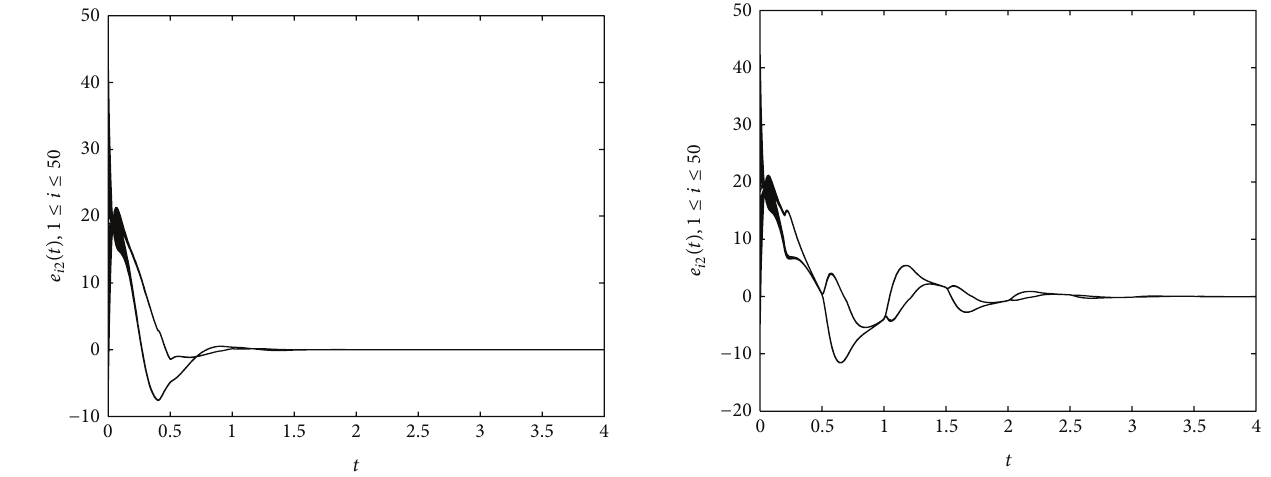
Figure 6: Synchronization errors 𝑒 𝑖 2 , 1 ≤ 𝑖 ≤ 50, with control parameters 𝑘 = 5, 𝑇 = 0 . 5, and 𝜃 = 0 . 4.